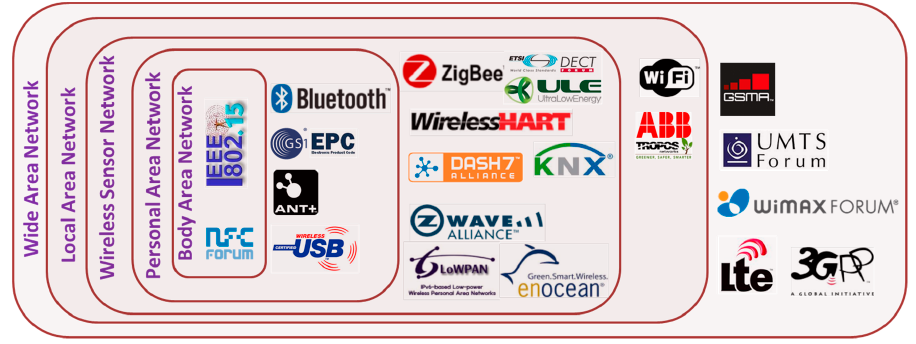
Figure 5. Fragmentation of wireless communication platforms.